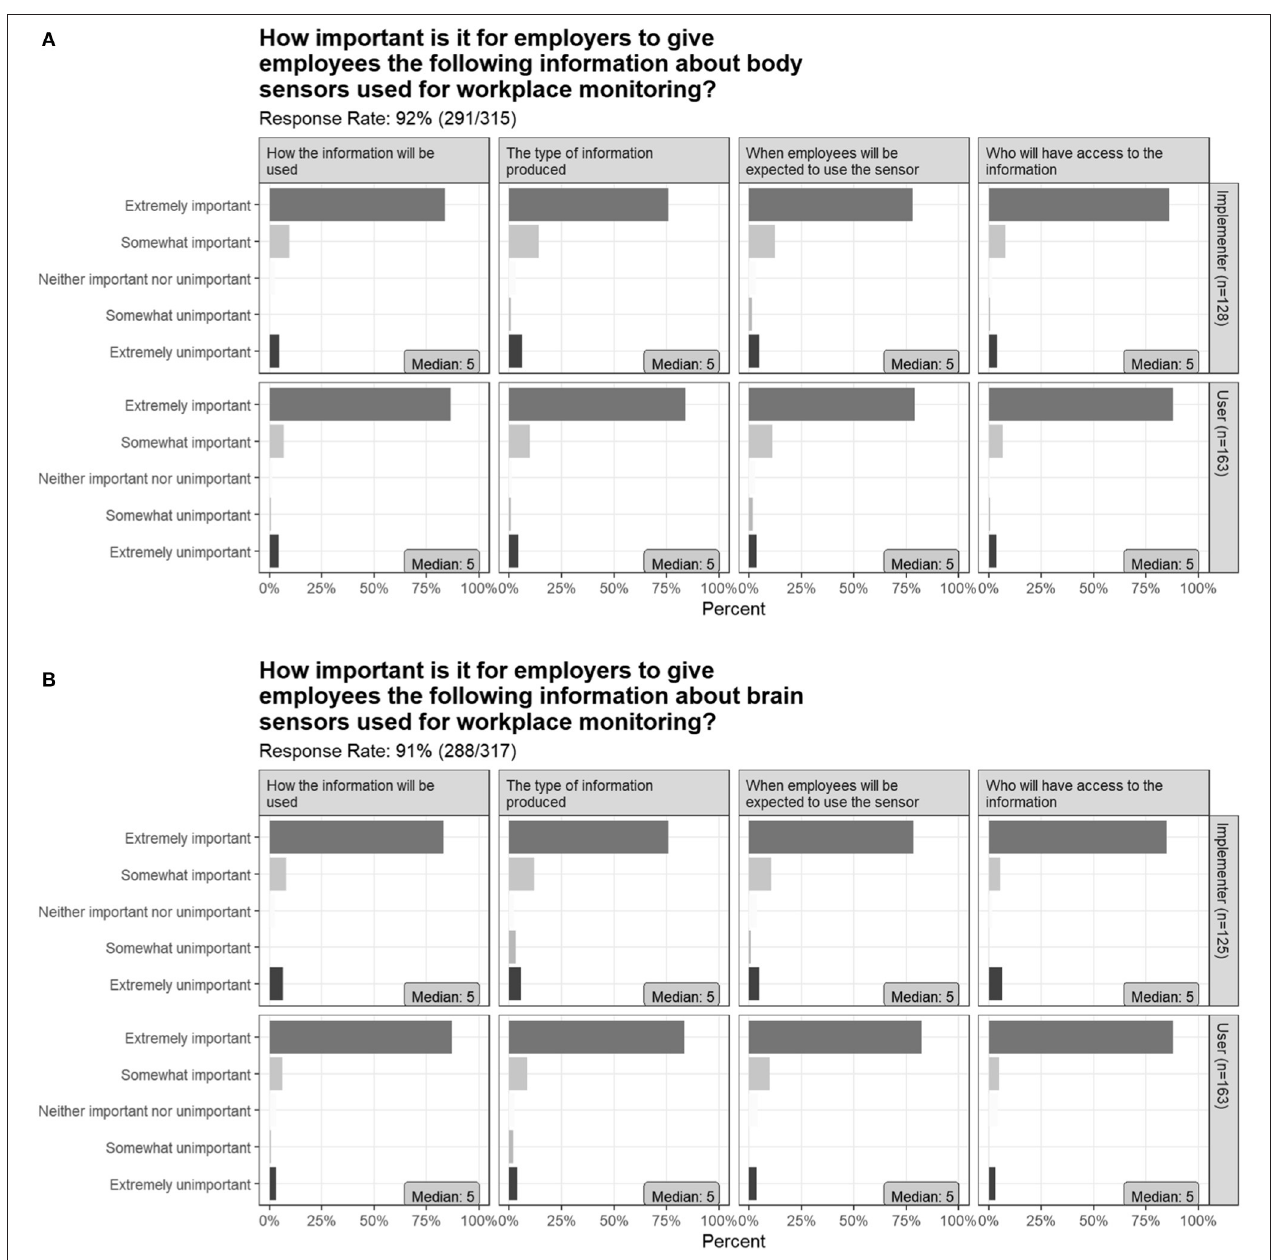
FIGURE 6 | Survey responses about the importance of employers sharing workplace brain sensor data with